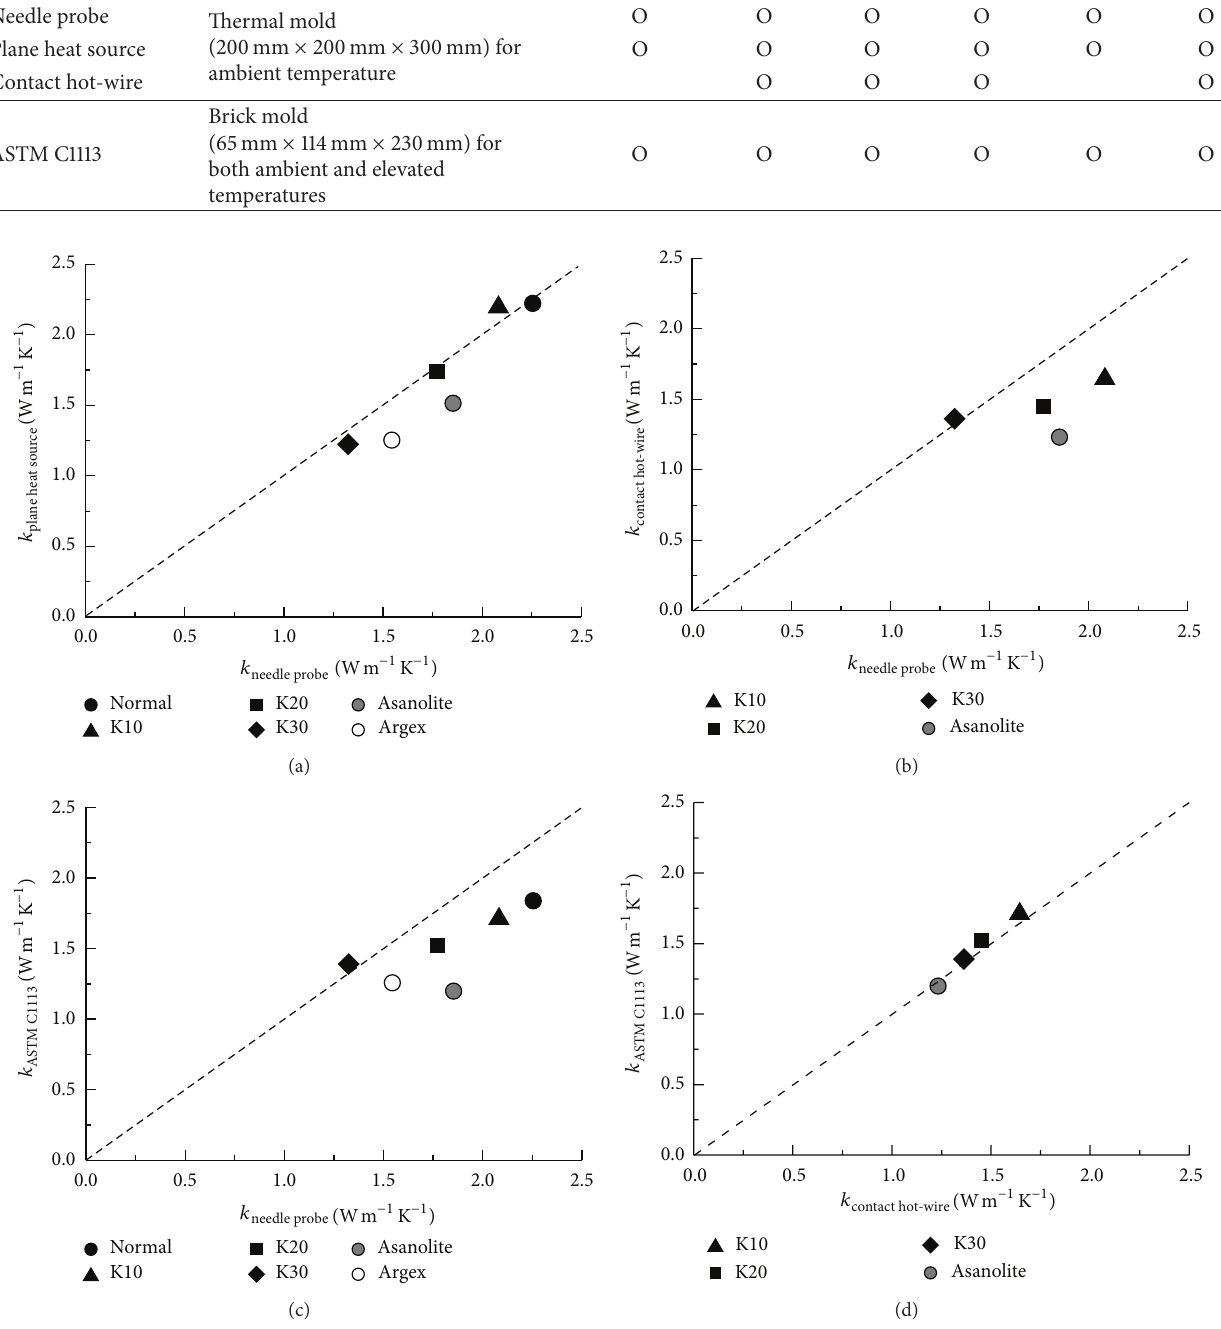
Figure 3: Thermal conductivity of tested specimens measured by various